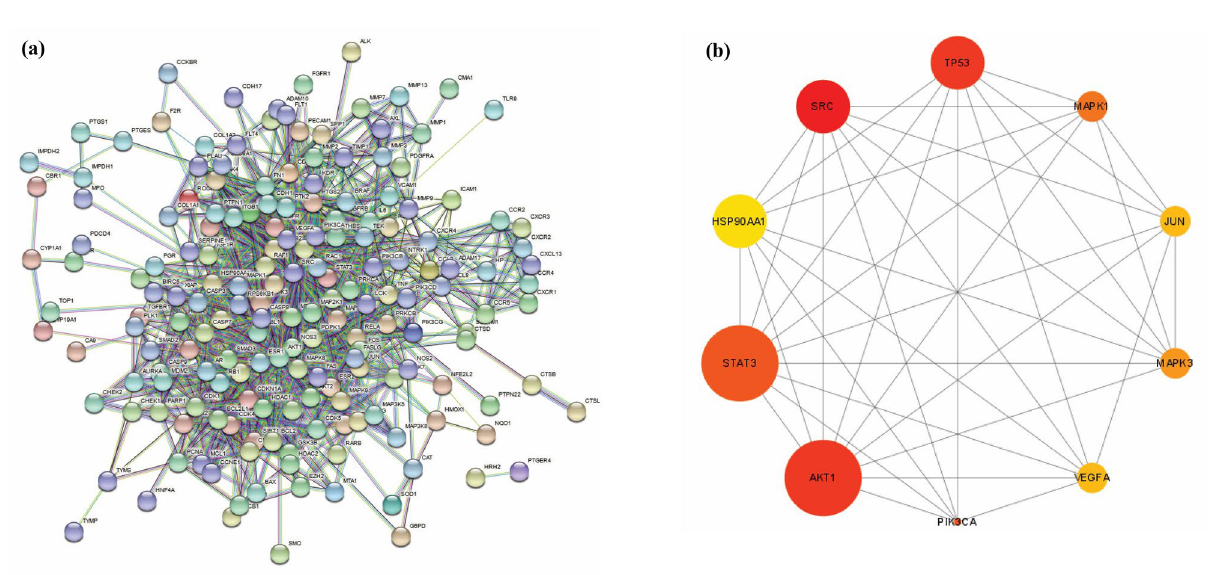
Figure 5. Protein–protein interaction (PPI) network and Hub gene analysis. ( a ) PPI network performed by STRING database. Contains 197 common DEGs. (http:// string- db. org/; version 11.5). ( b ) PPI network of the top 10 hub genes generated by (Cytoscape plugin cytoHubba; https:// apps. cytos cape. org/ apps/ cytoh ubba; version 0.1) (the redder the colour, the more important it